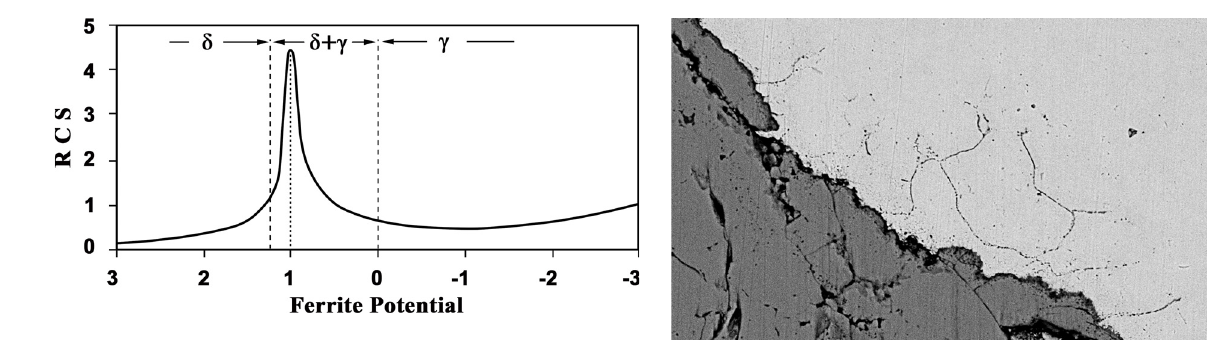
Figure 6: Relationship between the relative crack susceptibility (RCS) and ferrite potential (FP).